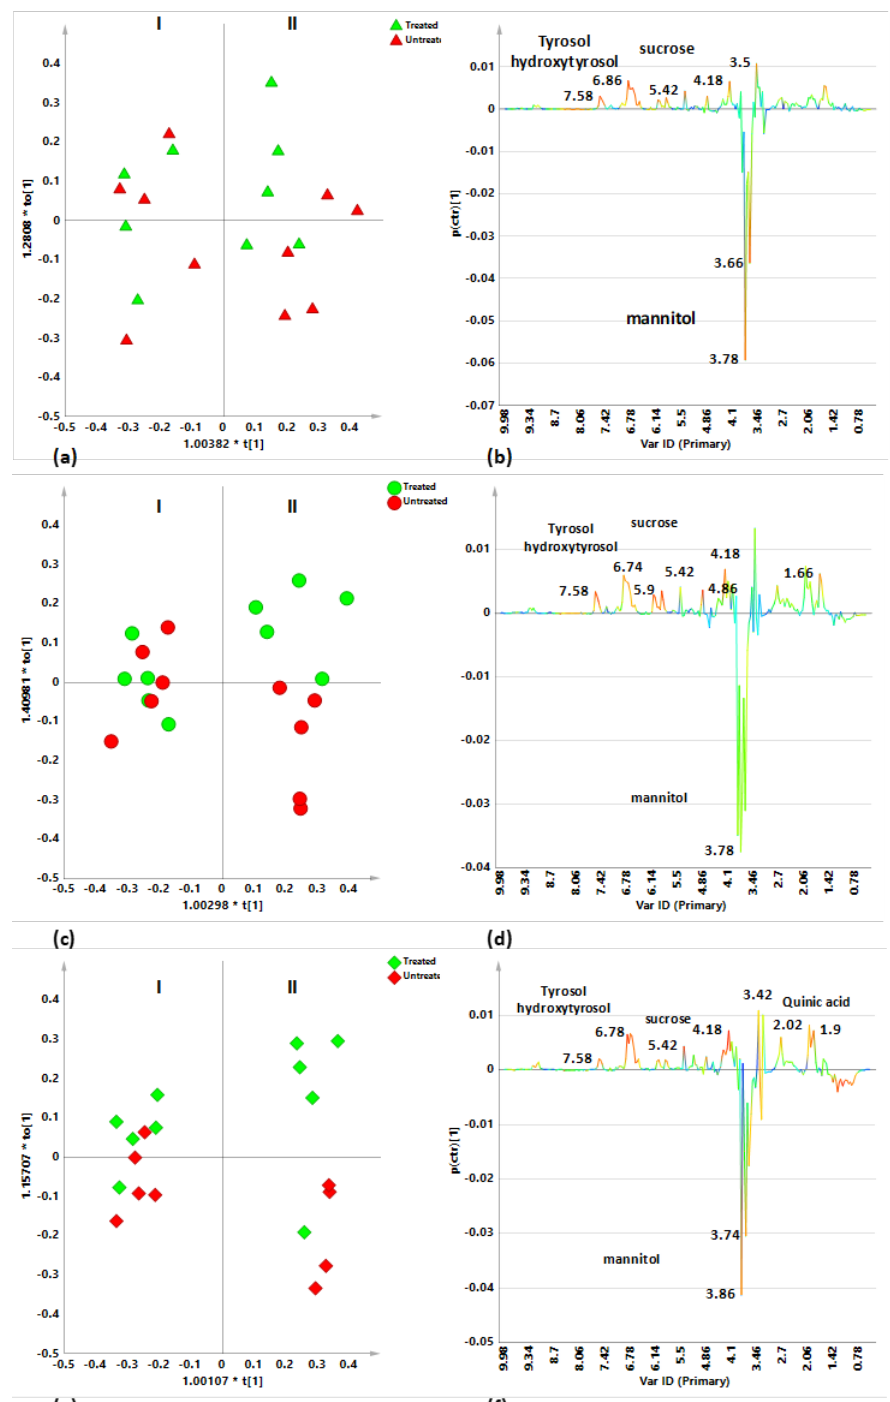
Figure 3. OPLS-DA t[1]/t[2] scores plot for infected Ogliarola salentina (triangle symbols) ( a ), Cellina di Nardò (circle symbols) ( c ) and Leccino (diamond symbols) ( e ), leaf samples related to I and II sampling periods. Red colored symbols indicated untreated sample. Green colored symbols indicated Dentamet ® -treated samples. ( b – f ) S-line plots for Ogliarola salentina ( b ), Cellina di Nardò ( d ) and Leccino ( f ) related models visualizing the p(ctr)[1] loading colored according to the absolute value of the correlation loading, p(corr)[1].